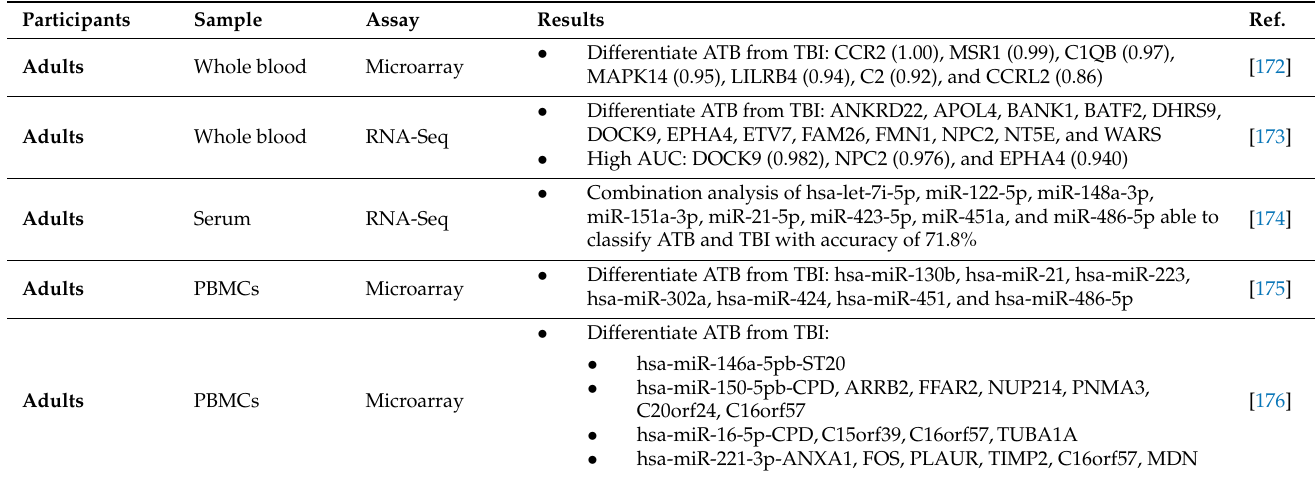
Table 4. mRNAs and miRNAs that significantly differentiate ATB and